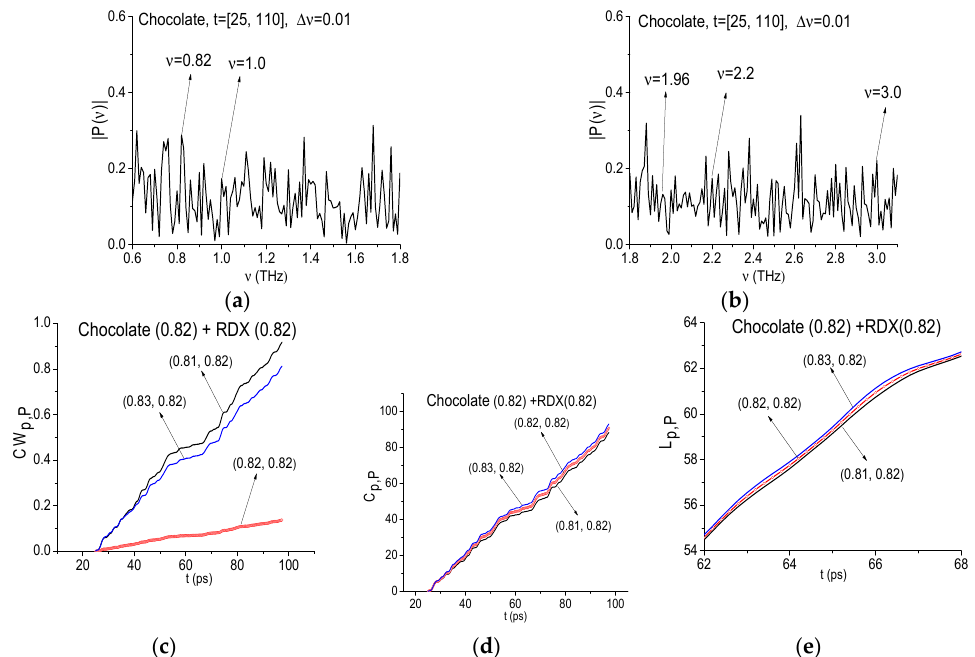
Figure 16. Signal Chocolate spectrum in the frequency ranges ν = [0.6, 1.8] ( a ); [1.8, 3.2] ( b ) calculated with the spectral resolution Δ ν = 0.01 THz. ICC CW p,P ( c ), C p,P ( d ), L p,P ( e ) for frequency ν = 0.82 THz and signal Chocolate and RDX_Air as a standard one.